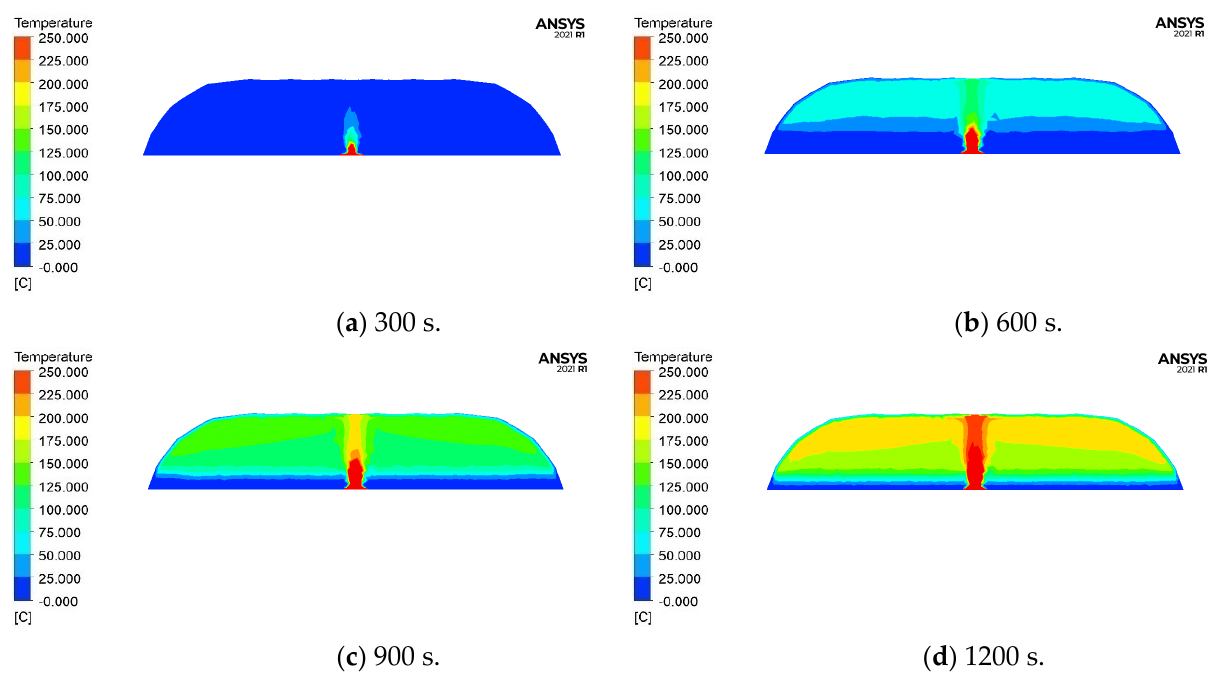
Figure 6. Temperature of the structure in the normal-grow fire event.